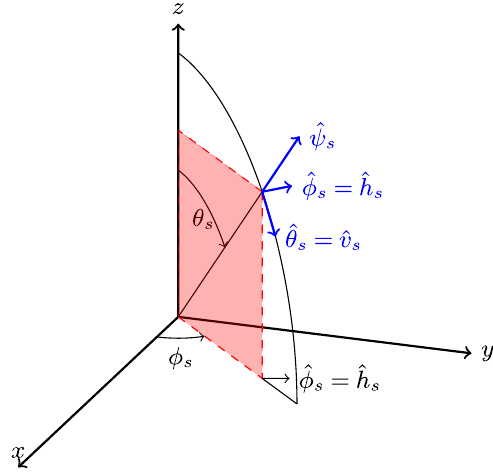
Figure 5. The direction of the far-field scattered wave is given by the spherical angles θ s and φ s , or by the unit vector ˆ ψ s . In the FSA convention, the horizontal and vertical unit vectors are defined as ˆ h ˆ φ ˆ φ s = s and ˆ v s = s . The unit vectors for the spherical coordinate system form the triplet ( ˆ ψ s , ˆ θ s , ˆ φ s ) , which in the FSA convention becomes ( ˆ ψ s , ˆ v s , ˆ h s ) , with ˆ ψ s = ˆ v s × ˆ h s . This figure was adapted from Bringi and Chandrasekar